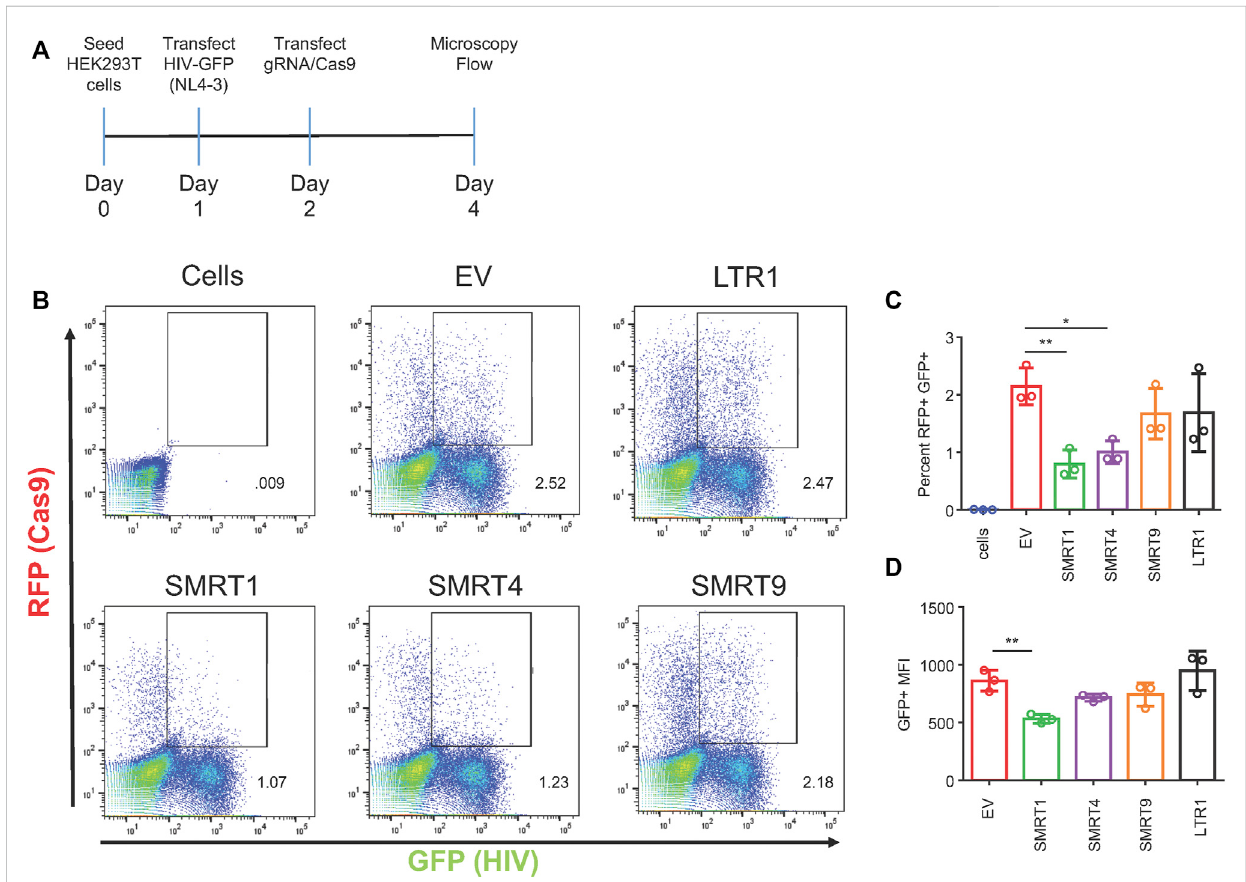
FIGURE 3 Only gRNAs targeting TAR are able to signi fi cantly reduce viral gene expression in a post-exposure setting. HEK-293T cells were transfected with HIV-1 GFP plasmid for 18 h. After the 18-h incubation, cells were transfected with the all in one Cas9 plasmid. Forty eight hours after transfection with Cas9, cells were processed for fl ow cytometry. (A) A schematic of the experimental timeline. (B) Representative FACS plots showing gating for double- positive cells. (C) Quantitative representation of double-positive cells, (D) Mean fl uorescent intensity of GFP from double-positive cells. Error bars represent ± SD. Statistical signi fi cance was determined by using a One-way ANOVA with multiple comparisons. p = * < .05, ** < .01. Data was collected from three independent experiments. Fifty thousand events were collected from each treatment